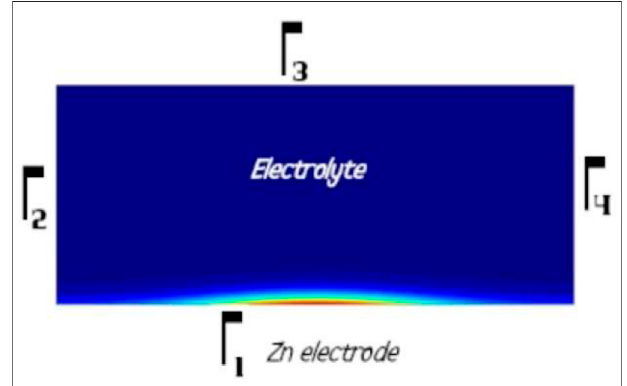
FIGURE 2 | General 2D simulated system. The border Γ 1 represents the Zn surface in contact with the electrolyte; Γ 2 , Γ 3 , and Γ 4 represent the borders of the electrolyte in contact with the air (where the O 2 concentration is fi xed as 0.26( mol/m 3 )). The electrolyte is considered as the domain Ω of the problem.